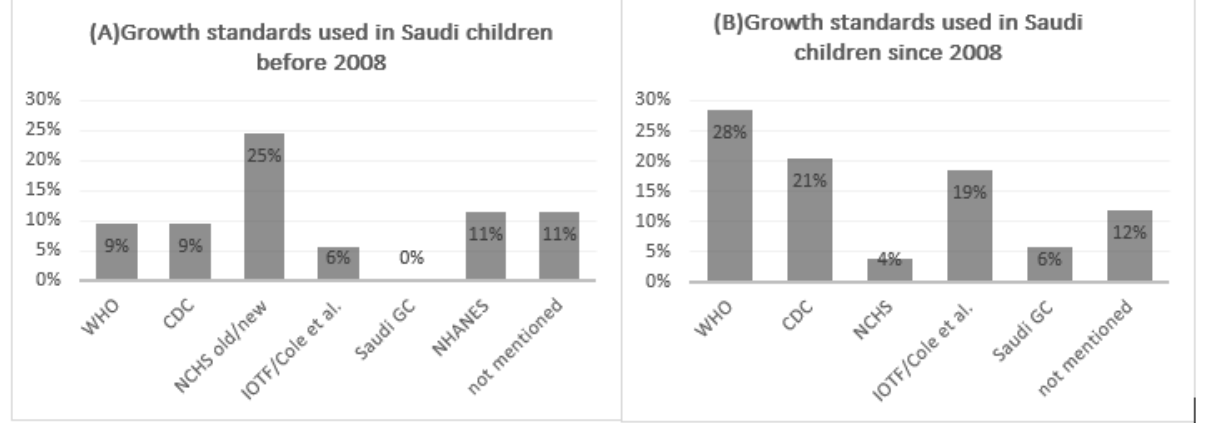
Figure 3. Growth standards used in research targeting Saudi children between 1980 and 2021. ( A